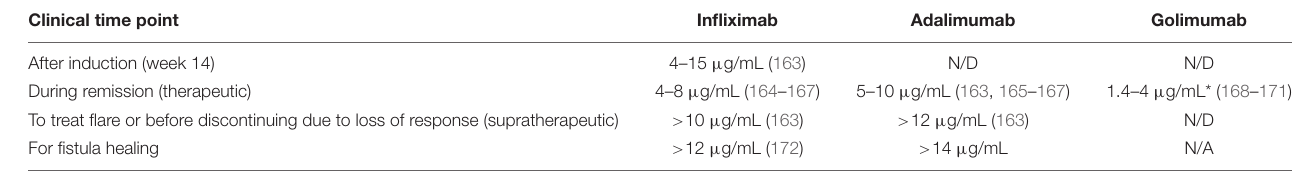
TABLE 2 | Proposed target levels of anti-tumor necrosis factors (anti-TNFs) for clinical decision making based on published data and expert opinion.